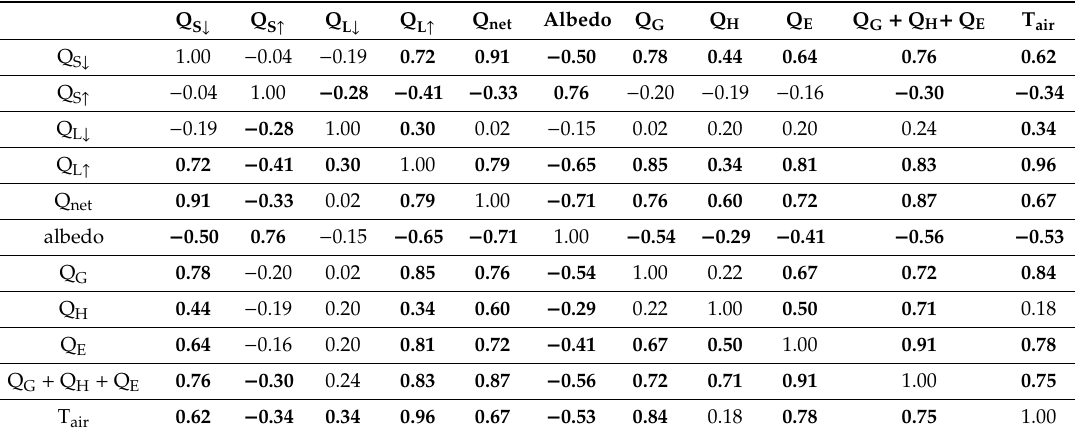
Table 4. Daily averages correlation matrix of shortwave downward radiation (Q S ↓ ), shortwave upward radiation (Q S ↑ ), longwave downward radiation (Q L ↓ ), longwave upward radiation (Q L ↑ ), net radiation (Q net ), albedo, ground heat flux (Q G ), sensible heat flux (Q H ), latent heat flux (Q E ), sum of fluxes (Q G + Q H + Q E ) and air temperature (T air ). Coe ffi cients in bold are statistically significant on significance level of 0.05. Study site and investigation period are the same as in Table